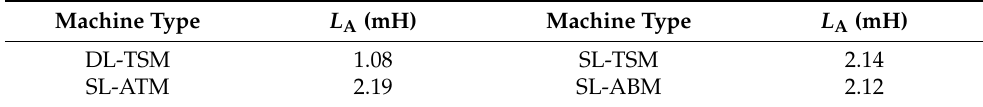
Table 3. Self-inductance for Different